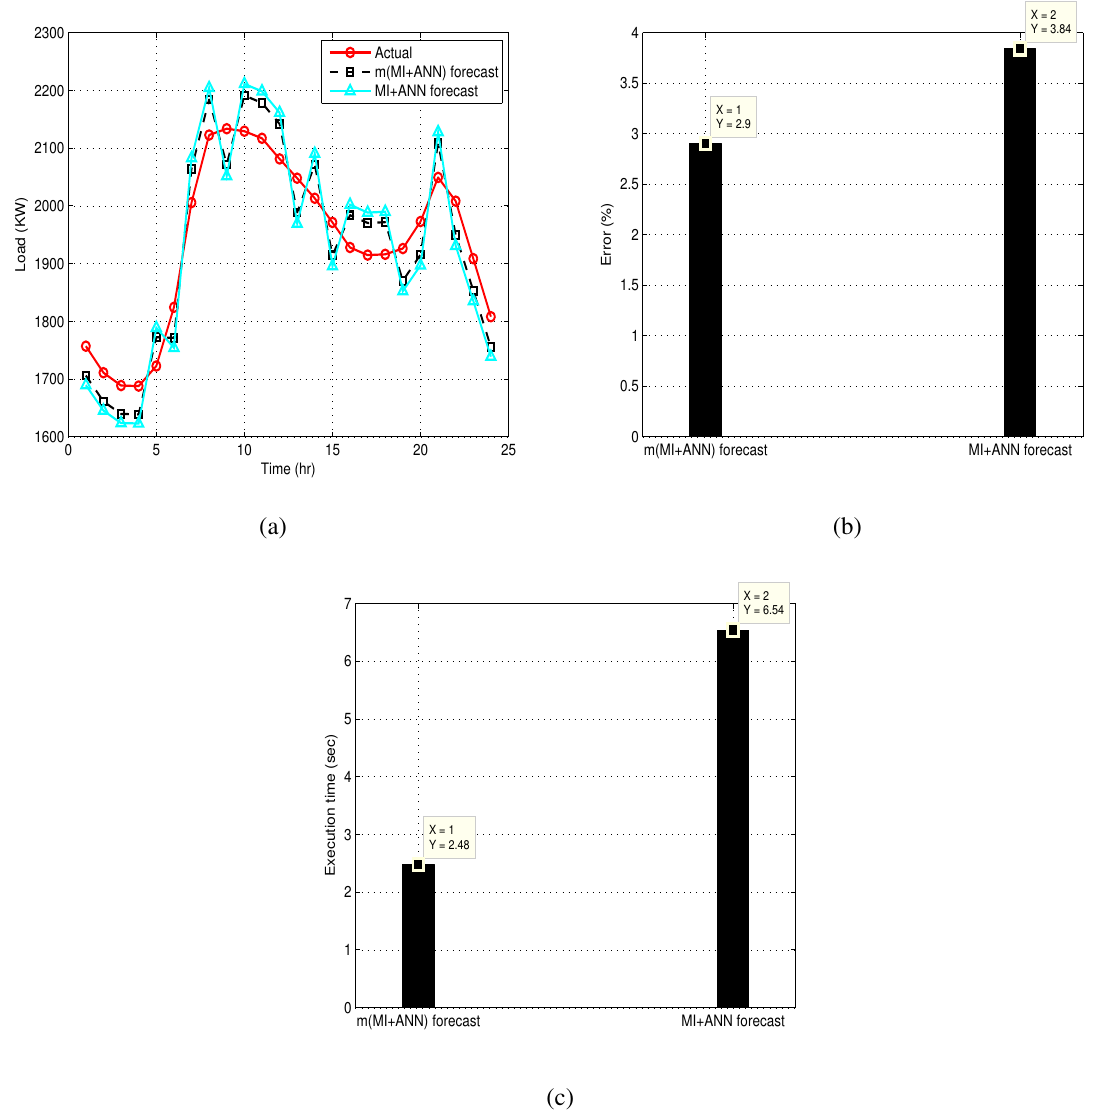
Figure 6. DAYTOWN (27 January 2015): m(MI + ANN) forecast vs. MI + ANN forecast. ( a ) Actual vs. forecast; ( b ) error performance; ( c ) convergence rate